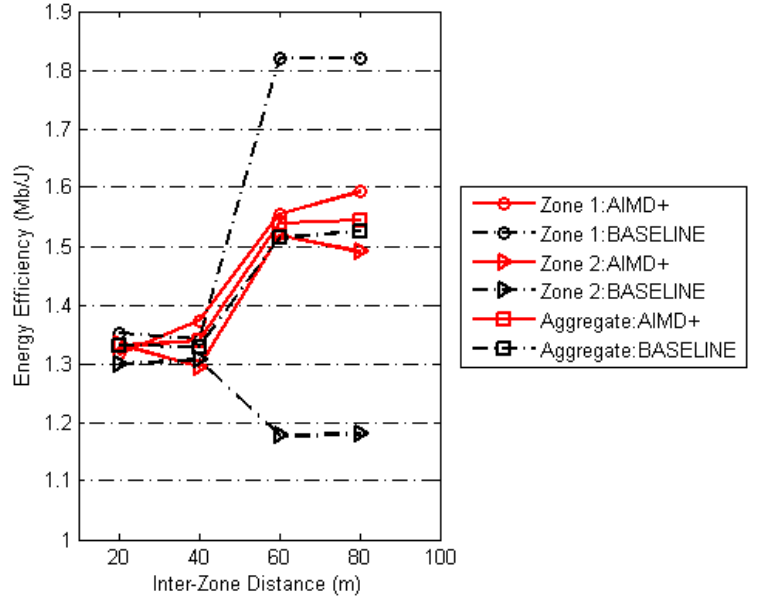
Figure 12. Comparison of AIMD+ and baseline with varying inter-zone distance.